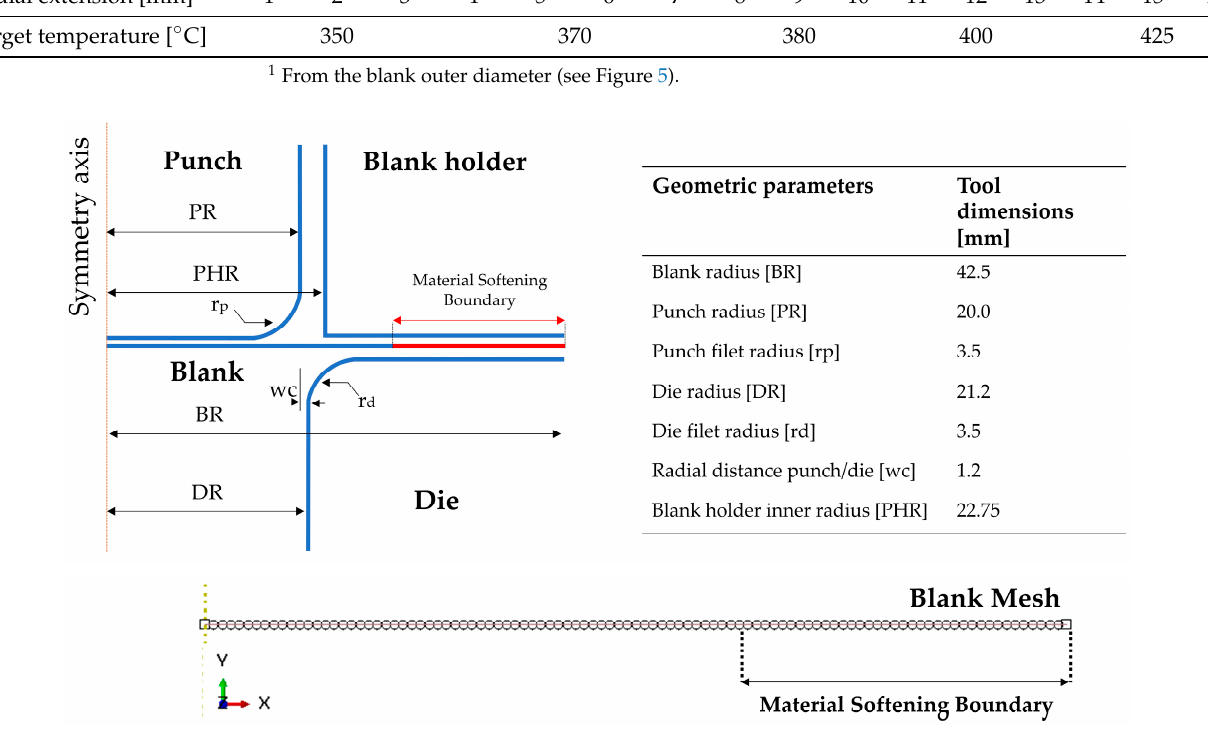
Figure 5. Schematic representation of the 2D deep drawing process, including main dimensions and mesh characteristics.